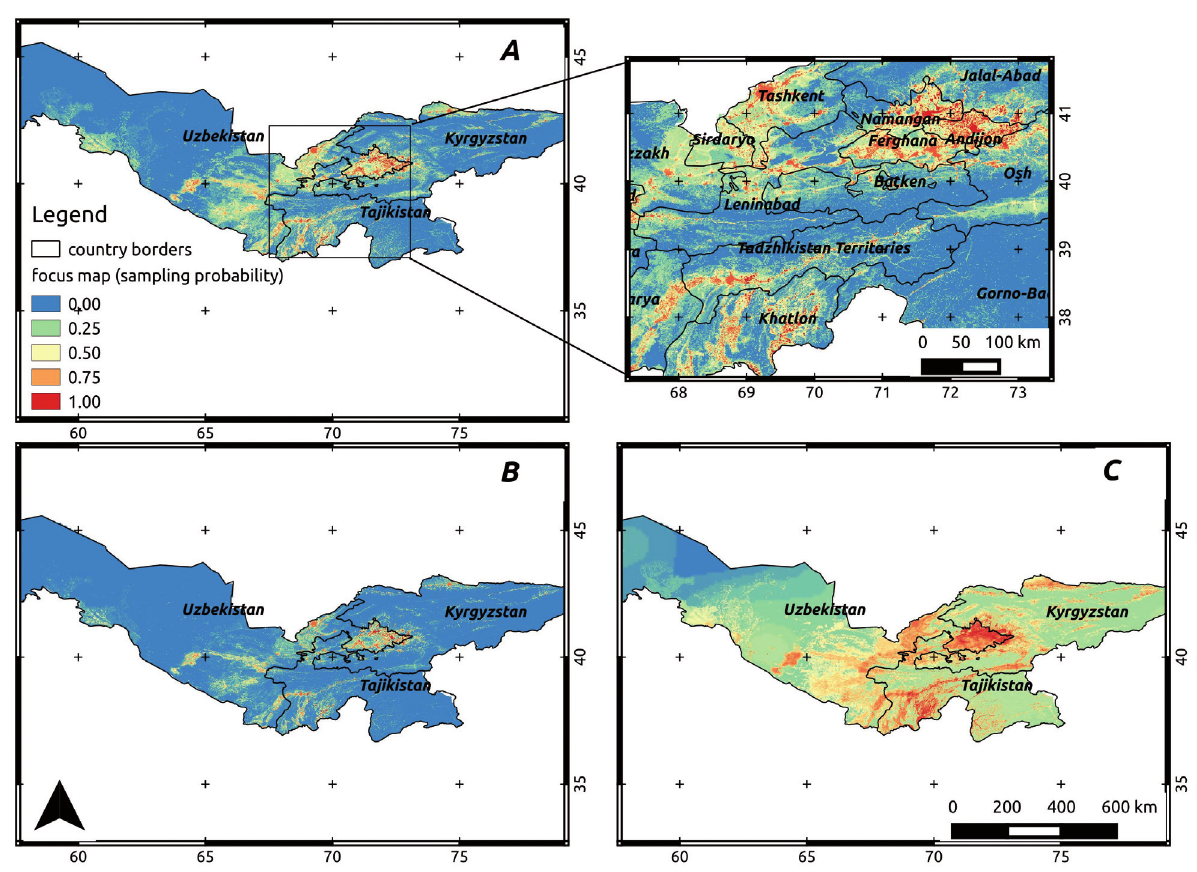
Figure 11. Comparison between focus maps obtained by loglinear pooling with different weighting schemes. A: equal weighting (w=0.5) B: equal weighting (w=1) C: unequal weighting (w=0.9 for seismic hazard layer. The inset shows a close-up of the area with a higher sampling probability, focusing on the Ferghana